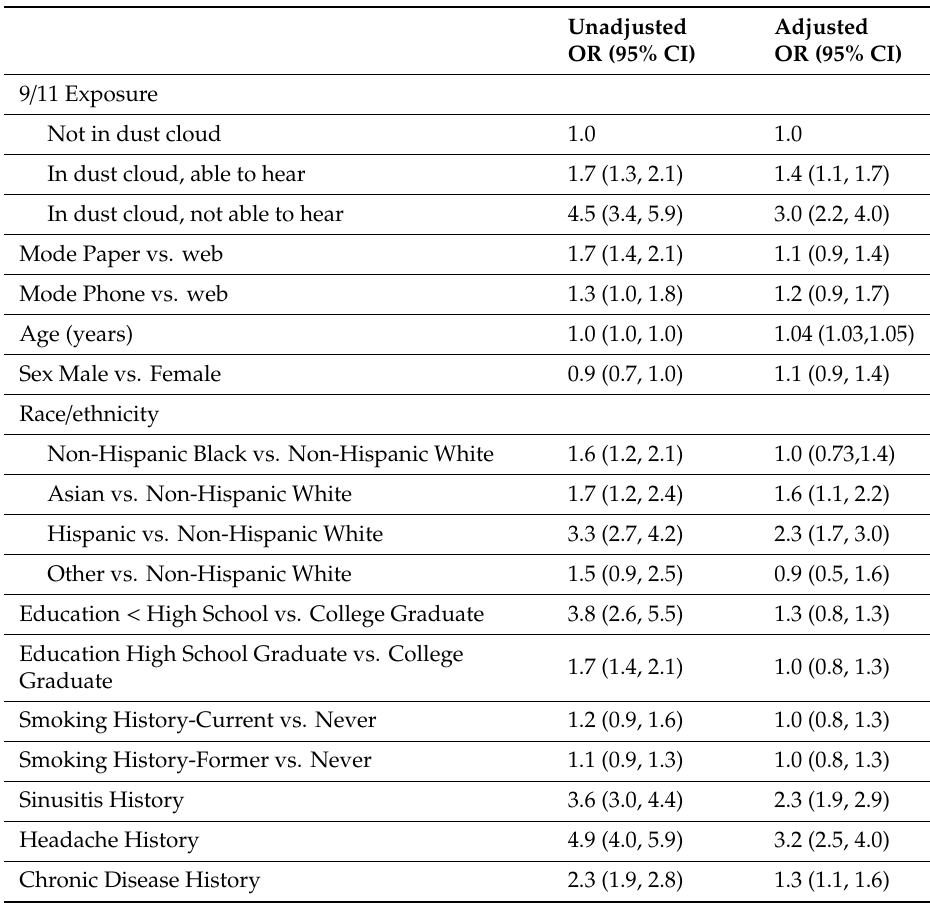
Table 2. Unadjusted and adjusted odds ratios (95% confidence intervals) for association between 9 / 11-related exposures and persistent self-reported hearing problems, World Trade Center Health Registry community enrollees,